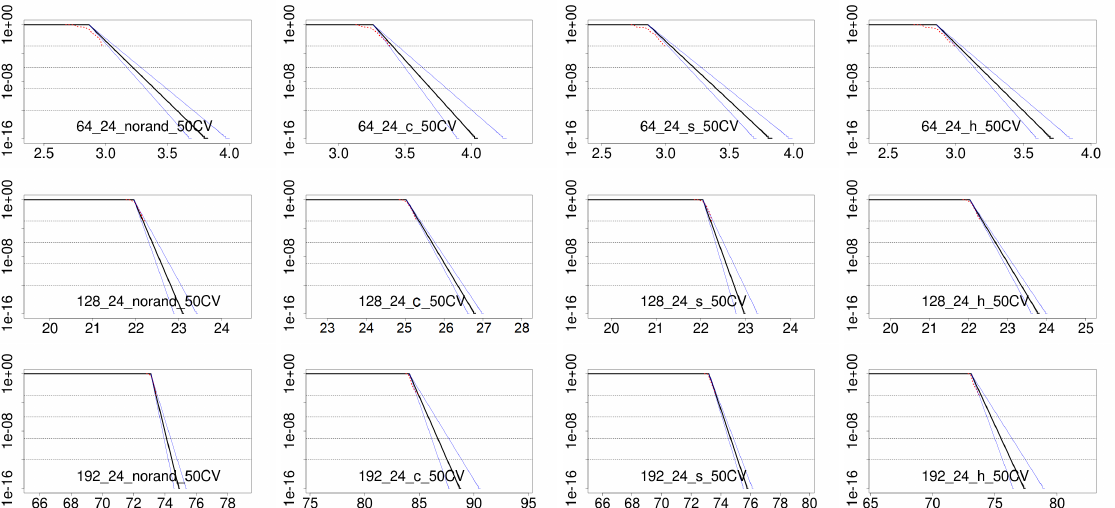
Figure 8. pWCET distributions for the FWI application with 24 threads. Plots correspond from top to bottom to 64 × 64 × 64 problem size, 128 × 128 × 128, and 192 × 192 × 192; and from left to right to no randomization, code randomization, stack randomization, and heap randomization